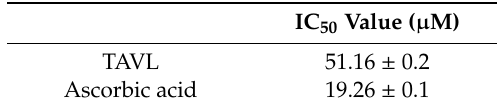
Table 3. Comparison with peroxyl radical scavenging activity by the tetrapeptide (TAVL) and ascorbic